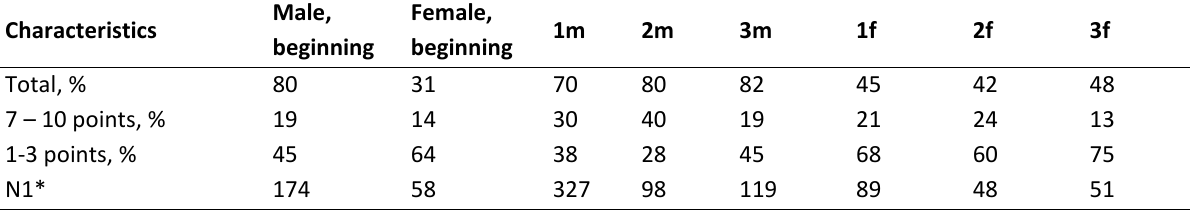
Table 2. Ubiquity of students’ computer games habits and their